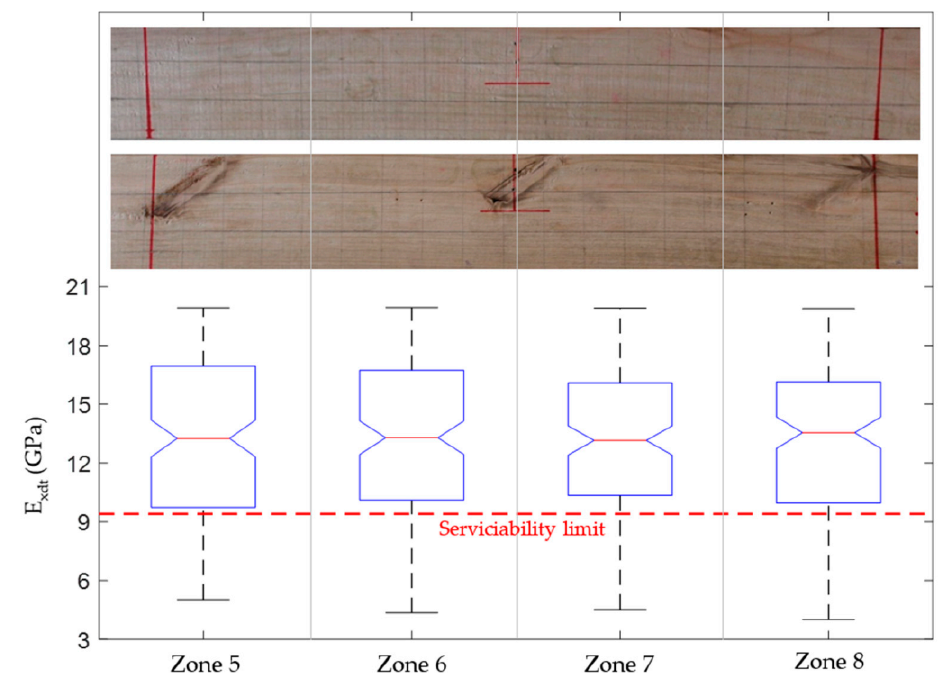
Figure 17. Boxplots of the four input factors located in the central third of the lumber board # 19 ( E xdt in zones 5 to 8) for B sets. The pictures show the back and front of the timber board in zones 5 to